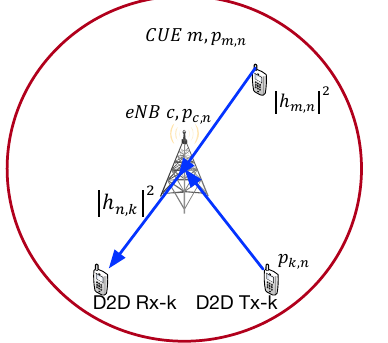
Fig. 1: Illustration of Device-to-Device cellular mode, showing the channel gains and the transmission powers of the di(cid:27)erent links